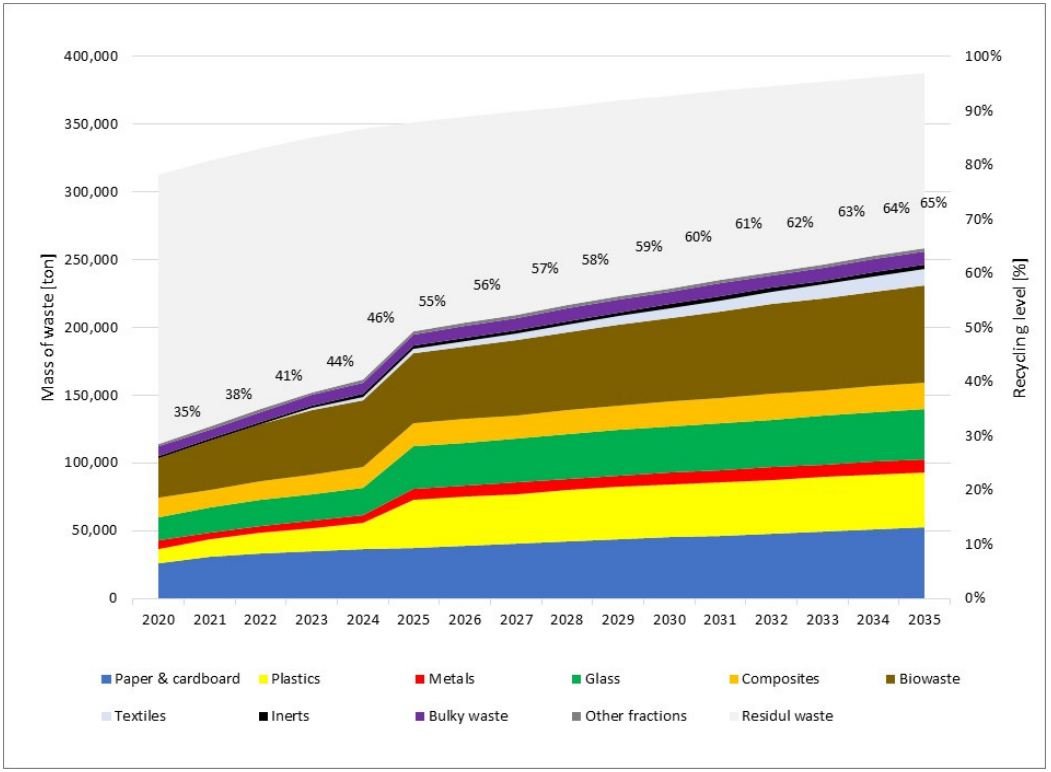
Figure 12. Prognosis of the individual recycling rates to comply with CE targets.